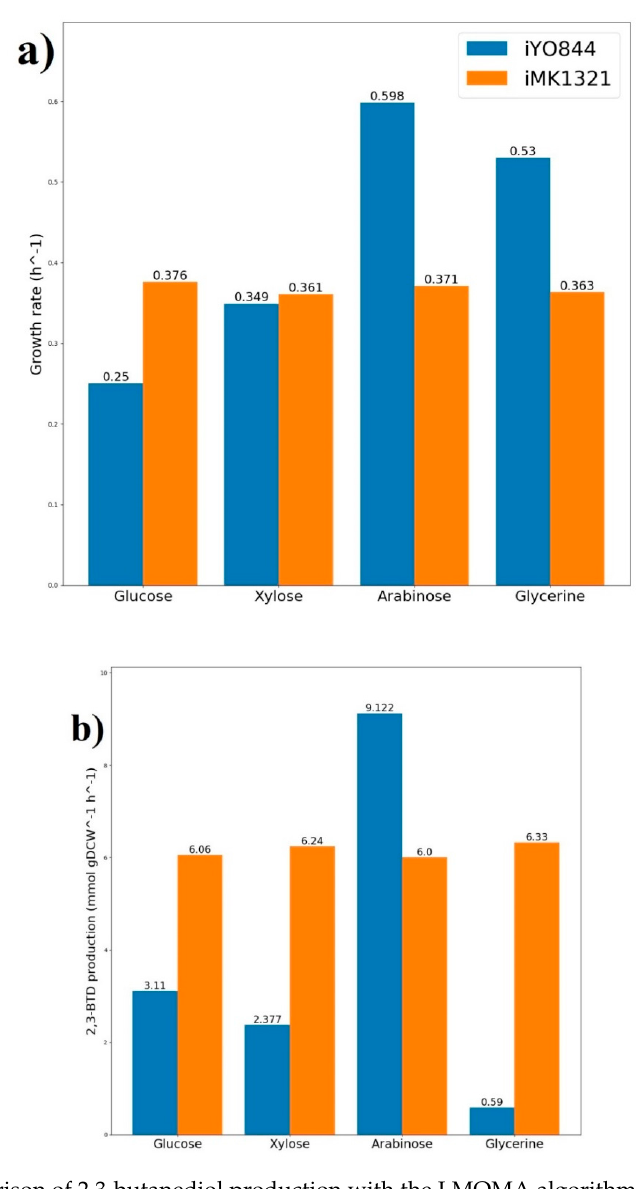
Figure 2. Comparison of 2,3-butanediol production with the LMOMA algorithm between iMK1321 (orange) and iYO844 (blue) models on different carbon sources: ( a ) growth rate ( b ) 2,3-butanediol production rate.